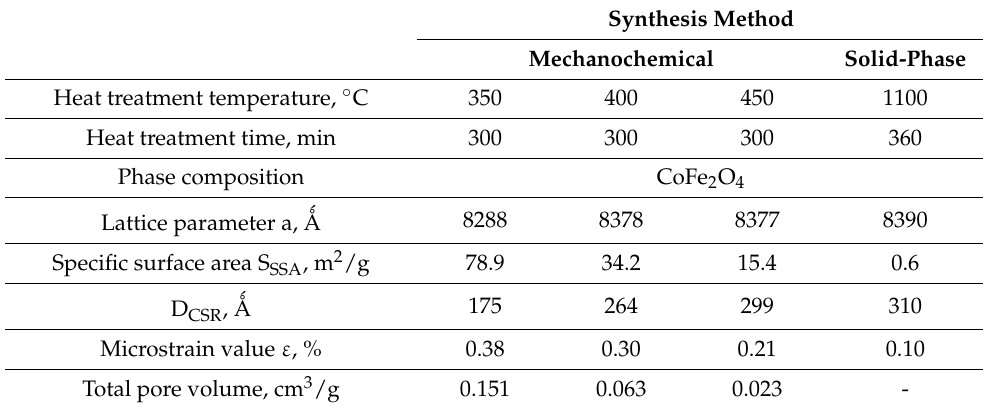
Table 2. Characteristics of cobalt ferrites obtained by various